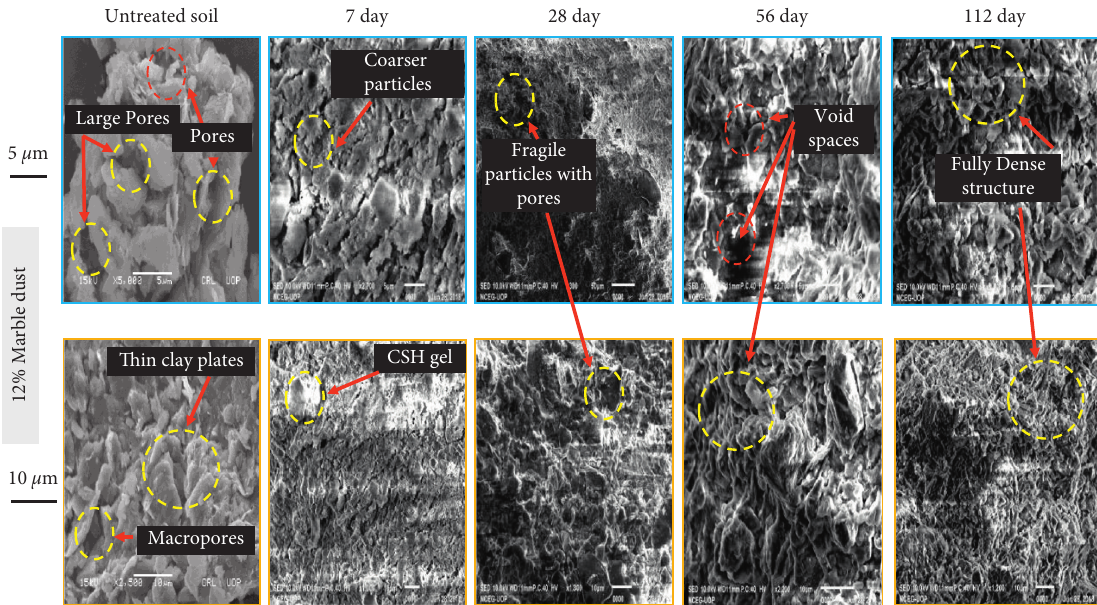
Figure 13: SEM micrographs of untreated expansive soil and 12% MD-blended soil samples cured at 7, 28, 56, and 112